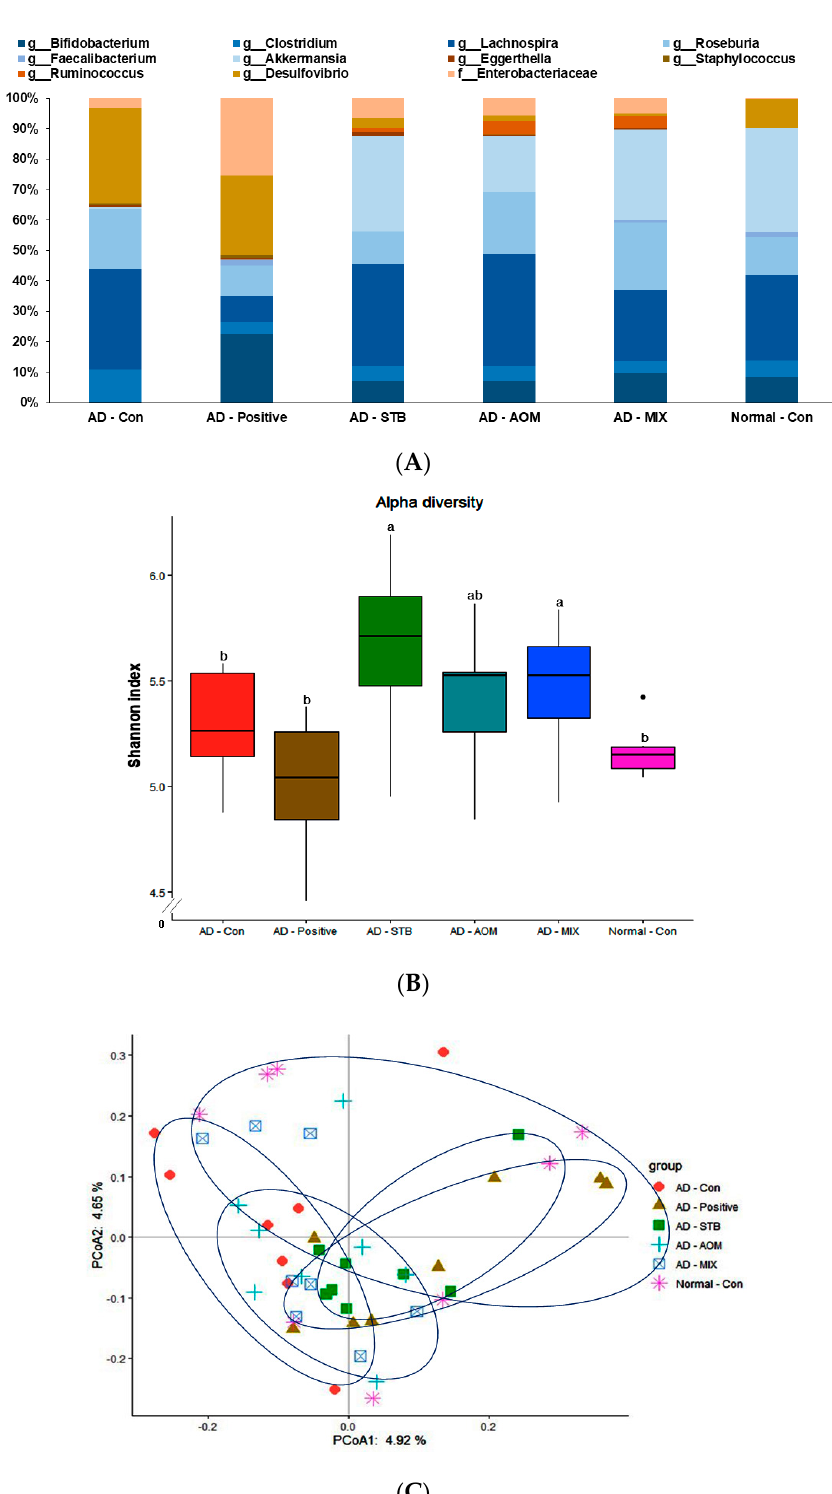
Figure 5. The profiles of gut microbiomes. After 5 weeks of the treatments, feces from the cecum were collected and the bacterial DNA was analyzed by the next generation sequencing method. ( A ) The relative amount (%) of fecal bacteria in the [order] level ( B ) The relative amount (%) of good bacteria for atopic dermatitis in the gut ( C ) The principal coordinate analysis (PCoA) of fecal bacteria. AD-Con vs Positive-C, AD-STB, AD-AOM and AD-MIX of R 2 were 0.0870 ( p = 0.016), 0.0863 ( p = 0.001), 0.0684 ( p = 0.355) and 0.0700 ( p = 0.256), respectively. Each value represents the mean ± SD of 5 mice in each group.